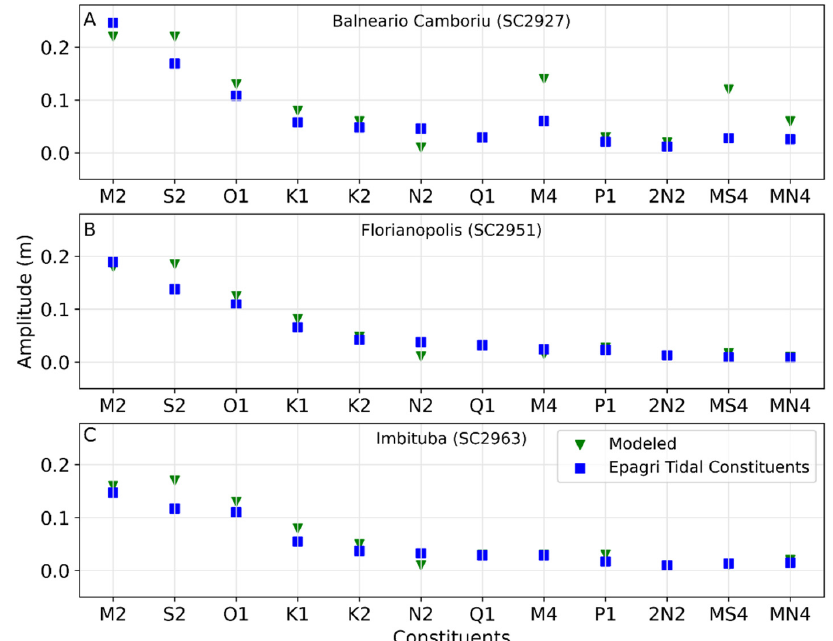
Figure 4. ( A – C ) Harmonic Constituents Amplitudes for three different stations in the Santa Catarina State coastal areas (locations shown in Figure 1).